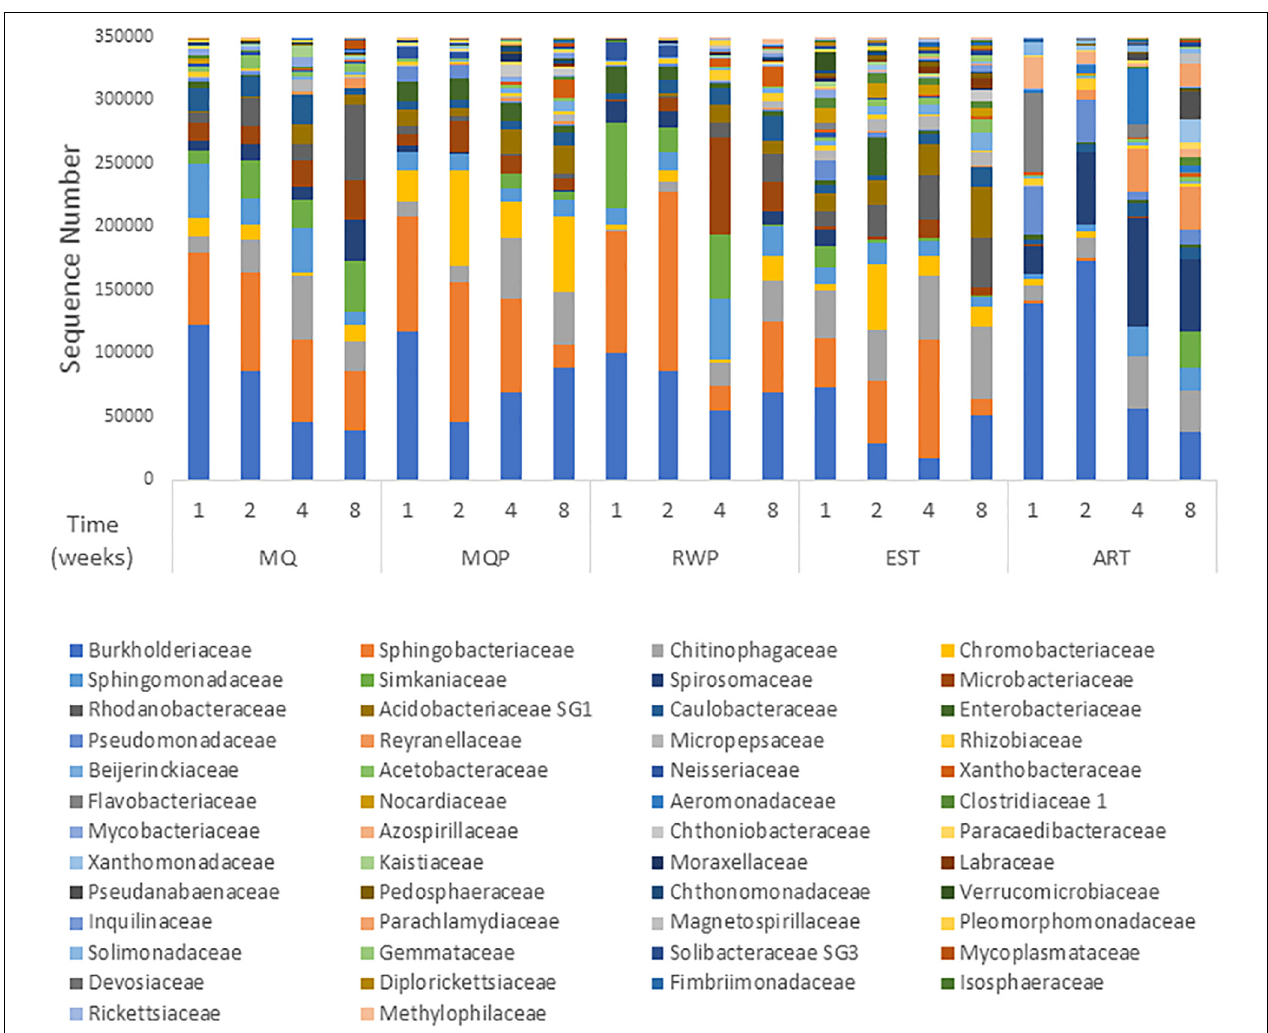
FIGURE 1 | Bacterial family composition of pitcher communities within each treatment at each of the four sampling times based on 16S rRNA amplicon sequencing of total community DNA in a greenhouse experiment. Sequences per treatment were normalized to the median sequence value for all samples, then plotted by abundance rank. Treatments are milliQ only (MQ), milliQ + prey (MQP), rainwater + prey (RWP), established community (EST), and artificial pitchers (ART) with sampling timepoints at weeks 1, 2, 4, and 8. Each bar represents the total abundances in all seven replicate pitchers within each treatment. Sequence abundances of families representing < 0.1% were